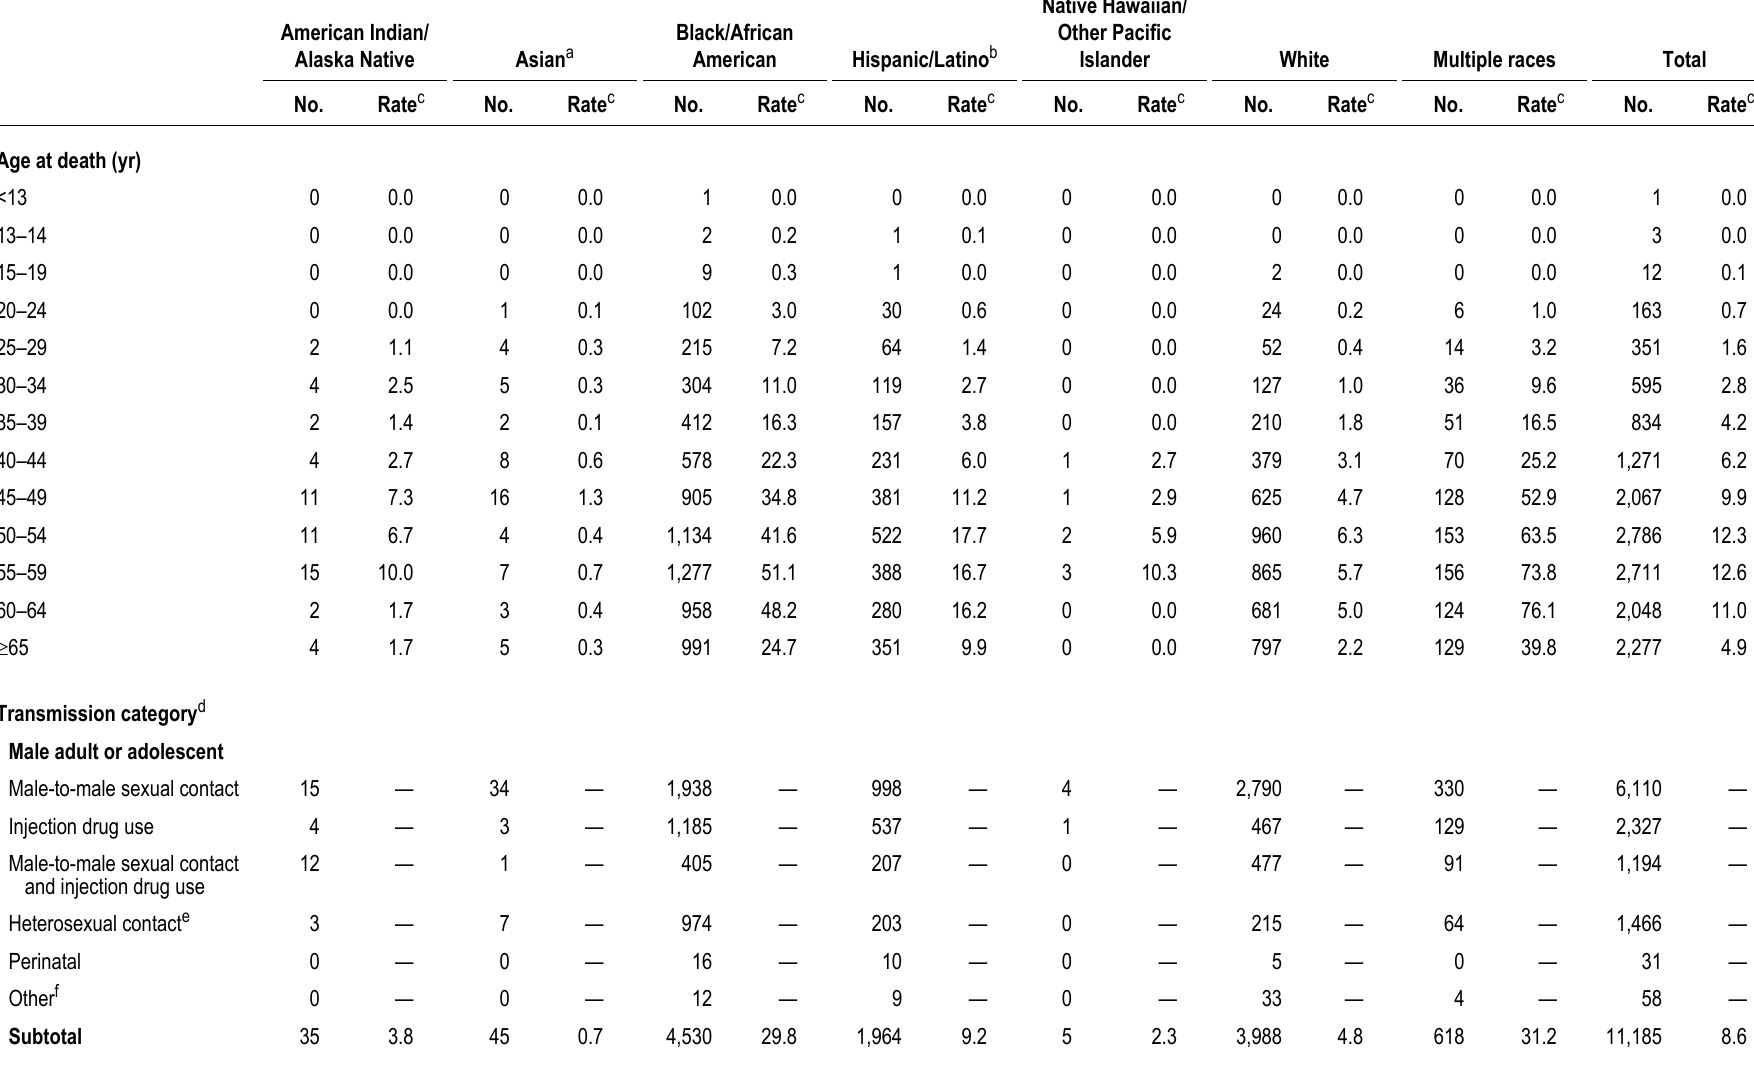
Table 14a. Deaths of persons with diagnosed HIV infection, by race/ethnicity and selected characteristics, 2014—United States American Indian/ Alaska Native Asian a